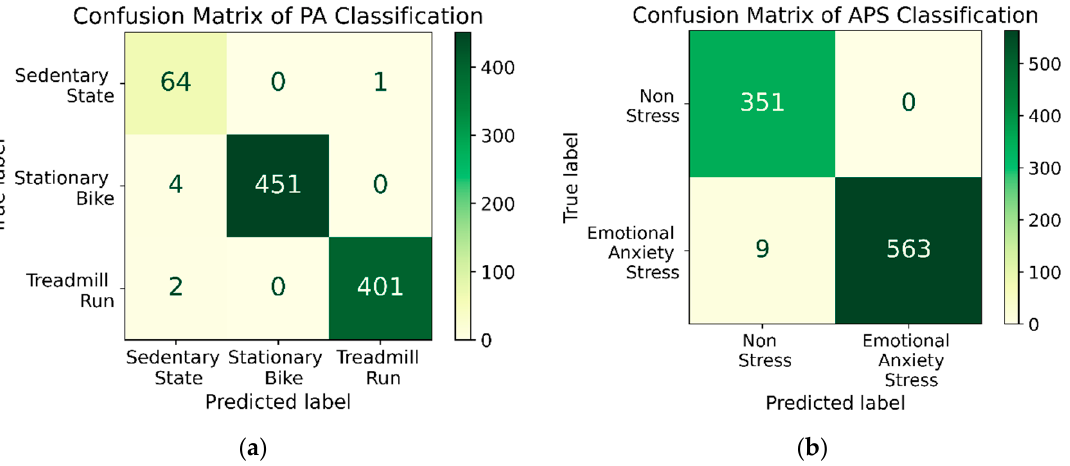
Figure 5. ( a ) Confusion matrix of PA classification using the multi-task LSTM RNN model designed to simultaneously perform classification of APS types, classification of PA types and estimation of EE; ( b ) Confusion matrix of APS types using the multi-task LSTM RNN model designed to simultaneously perform classification of APS types, classification of PA types, and estimation of EE which excludes the results for MS because not enough EE data were collected during MS sessions to do